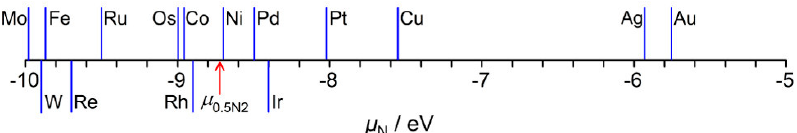
Figure 1. Value of the nitrogen chemical potential ( µ N) where the nitrogen covered surface becomes more stable than the clean metal surface; Reproduced from [18], with permission from American Chemical Society, 2018.